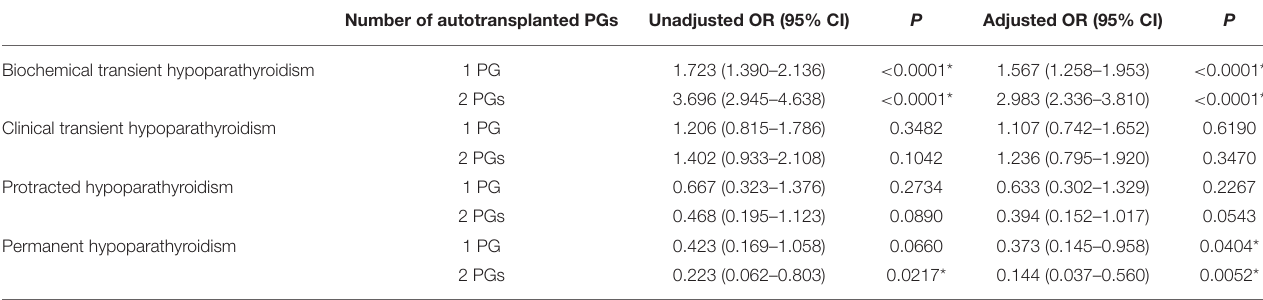
TABLE 3 | Parathyroid autotransplantation and risk of hypoparathyroidism. Number of autotransplanted PGs Unadjusted OR (95% CI) P Adjusted OR (95% CI)